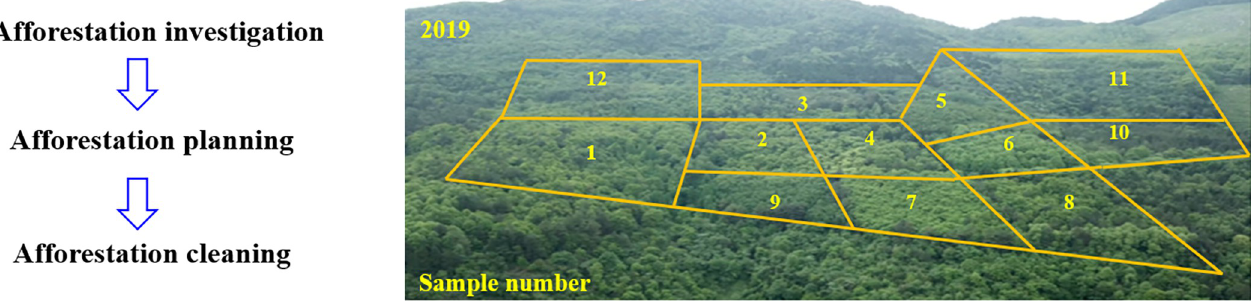
Fig 1. The basic information of the experimental